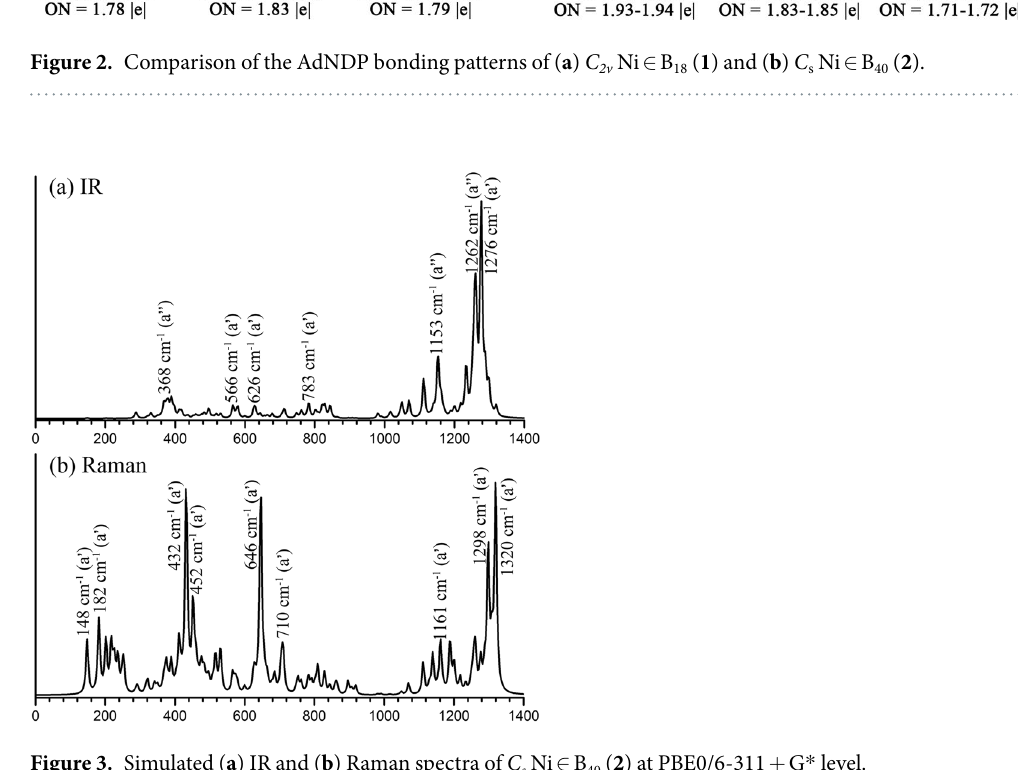
Figure 3. Simulated ( a ) IR and ( b ) Raman spectra of C s Ni ∈ B 40 ( 2 ) at PBE0/6-311 + G *